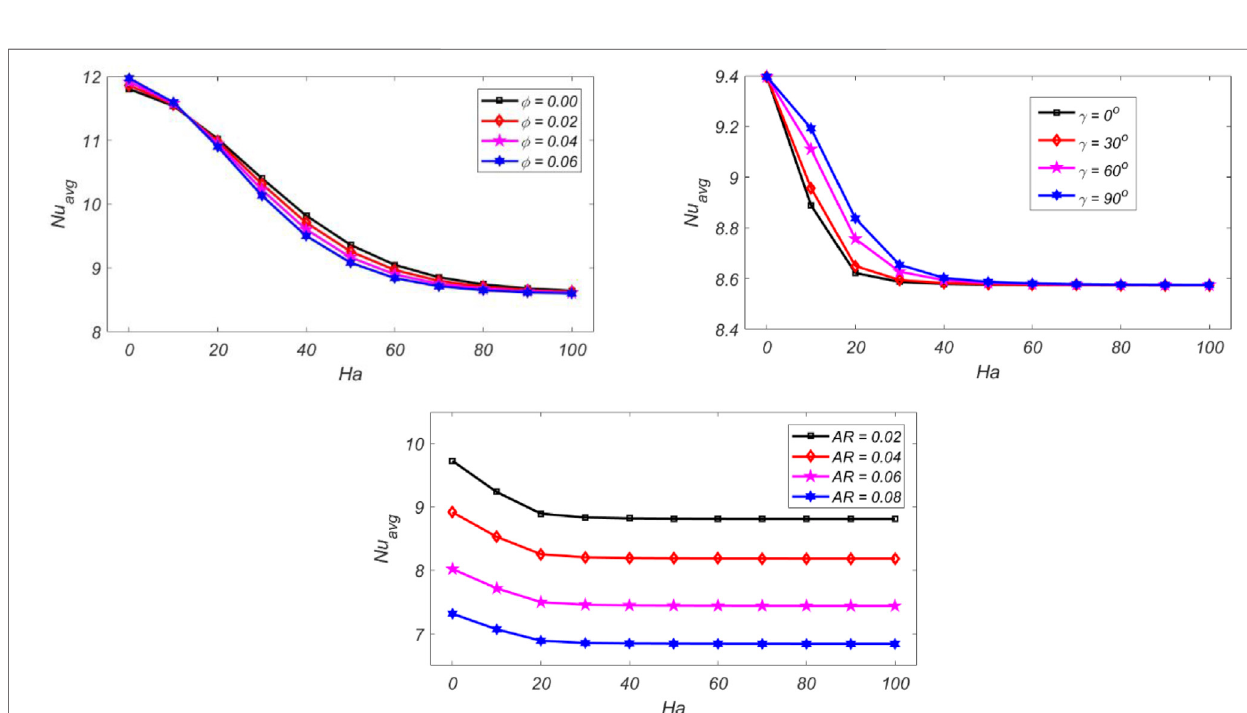
FIGURE 8 | Impacts on Nu avg against Ha for different parameters.